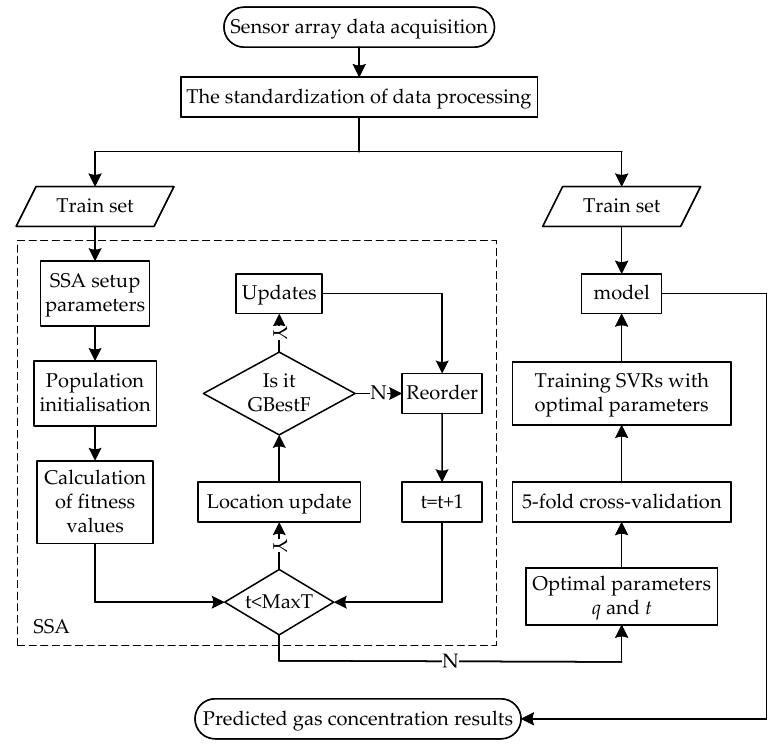
Figure 2. The SSA-SVR mixed-gas-concentration-prediction